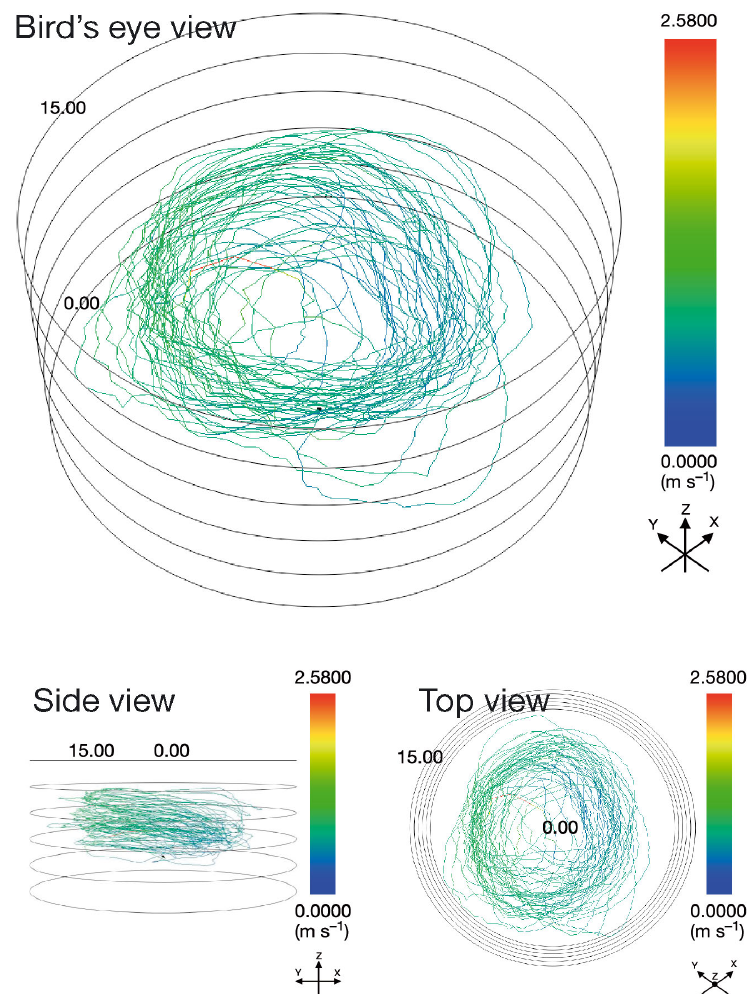
Fig. 4. Night-time (23:30 to 0:30 h) trajectories as reconstructed by the methods proposed in the present study. Colors of the trajectories